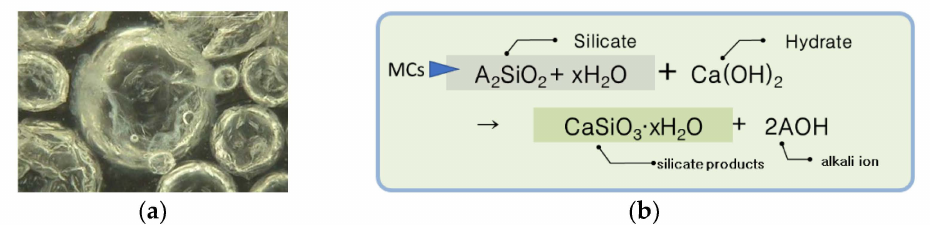
Figure 2. Microcapsules (MCs): ( a ) Sample of MCs ( × 300). ( b ) Reaction mechanism of MCs.